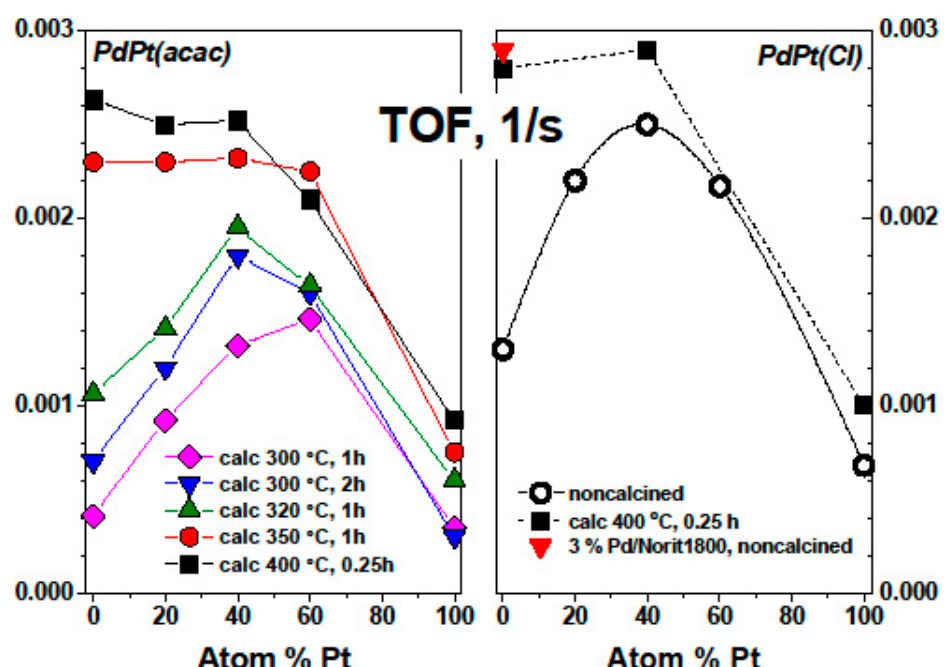
Figure 2. The effect of precalcination temperature on the relation between the turnover frequency (TOF) of Pd-Pt/Norit1600 catalysts and Pd-Pt alloy composition. The results for Pd-Pt(acac) catalysts precalcined at 300 °C and for Pd-Pt(Cl) non-calcined samples were taken from [17].